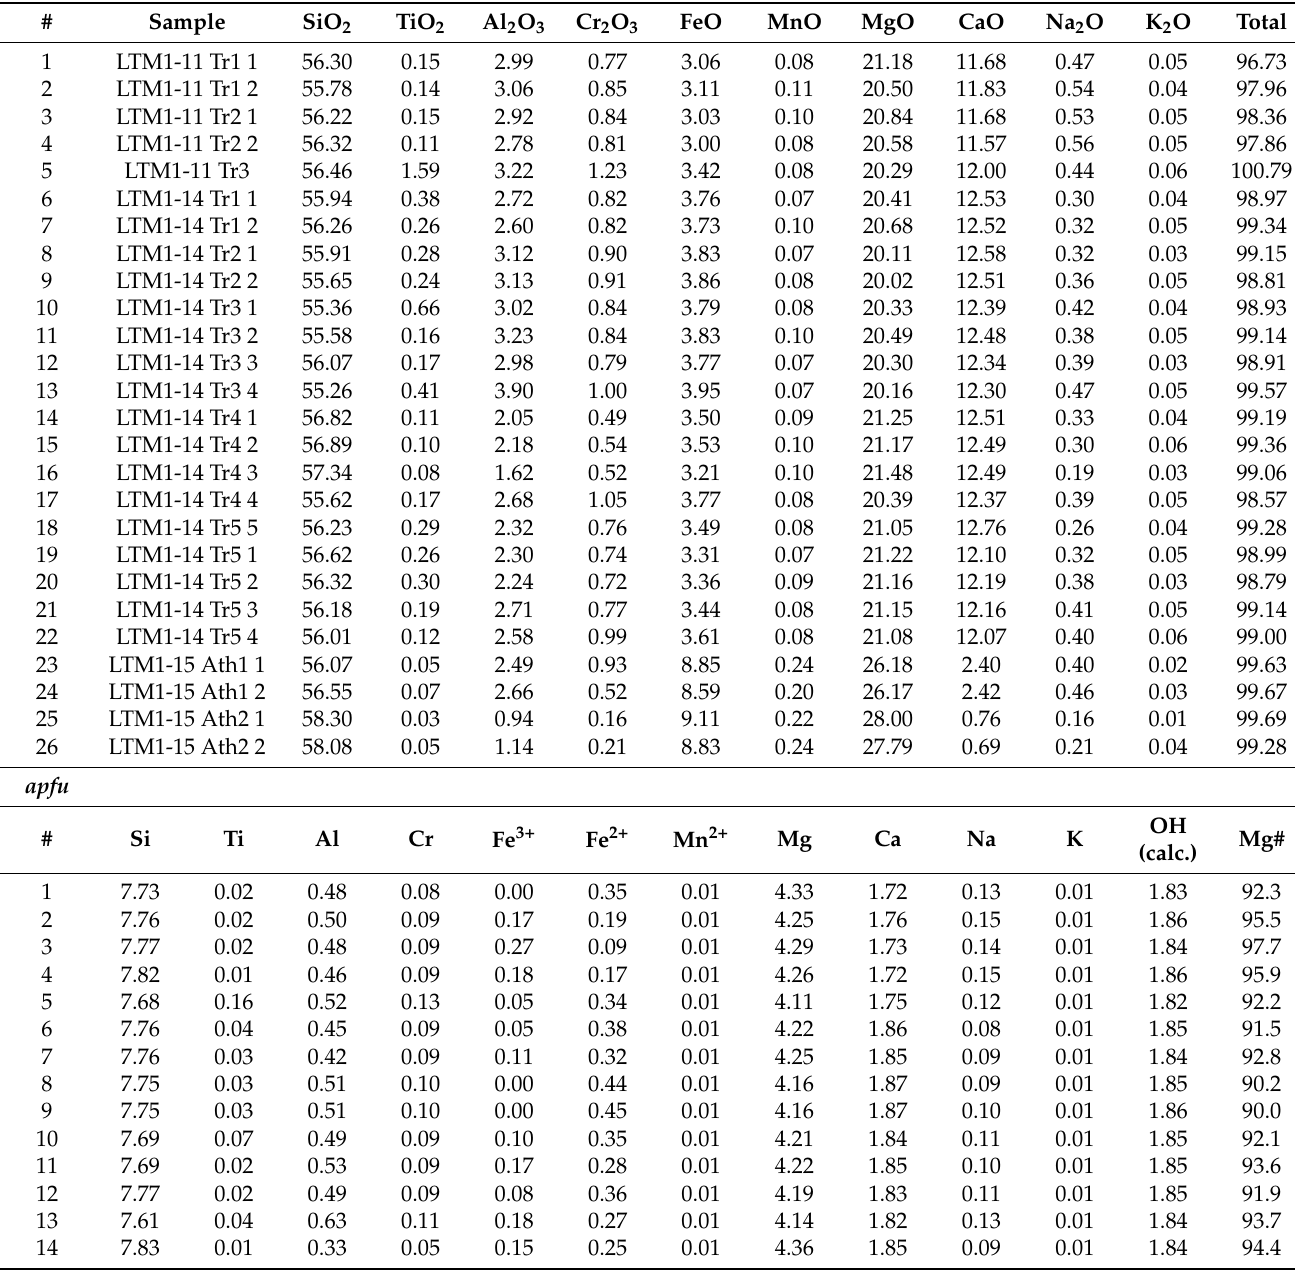
Table 2. Compositions of amphiboles in the orthopyroxenite zone of the Lotmvara-I sill, Kola